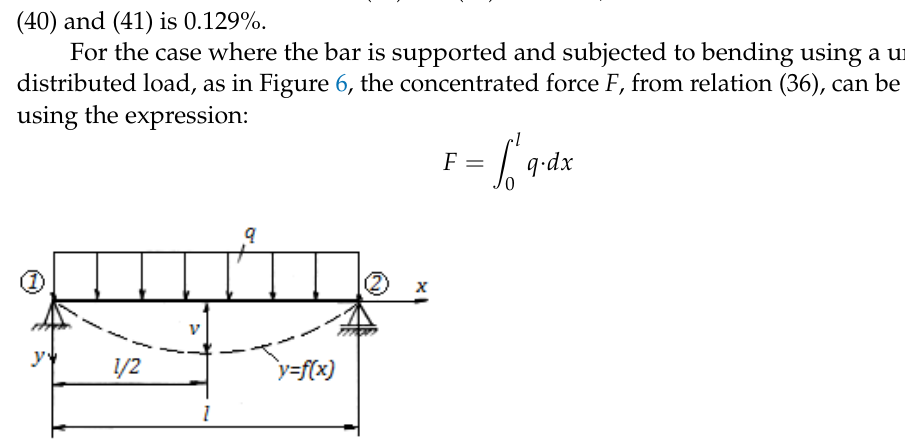
Figure 6. Simply supported beam, stressed using a uniformly distributed load, q